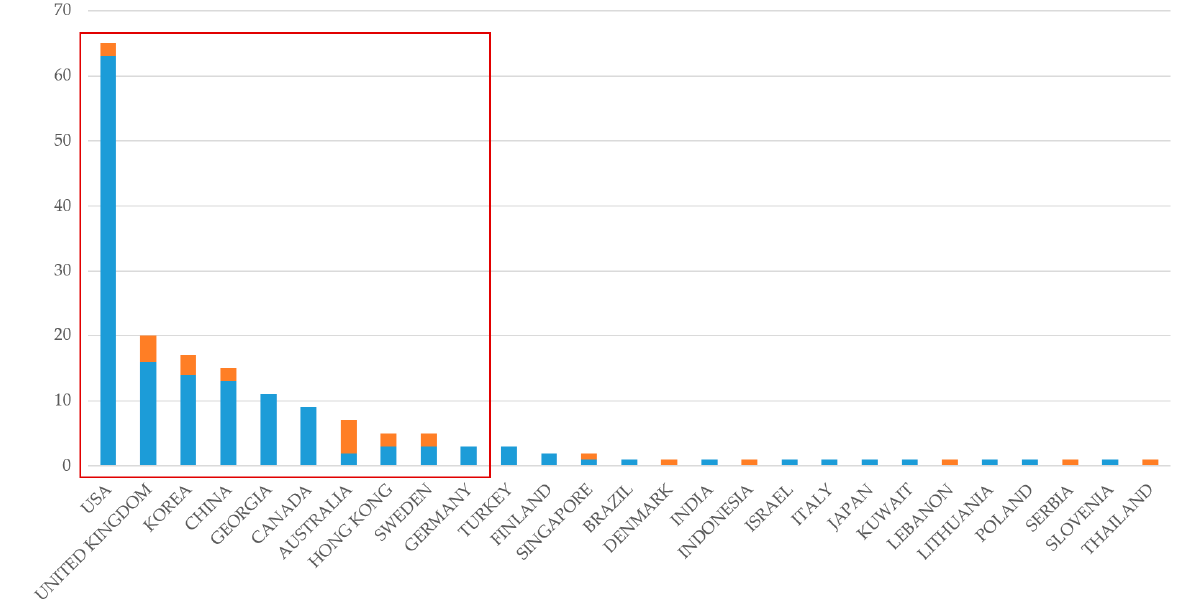
Figure 20. Research collaboration bar chart.